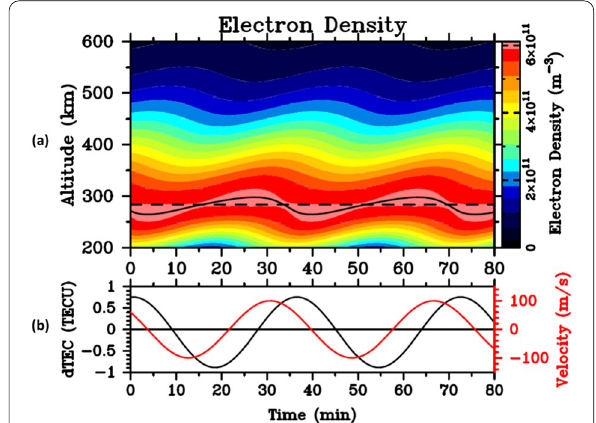
Fig. 8 a Model calculation of electron density in the F region for the case the electric field oscillating with a period of 36 min and B drift. Solid line and dotted line amplitude of 100 m/s for E × indicate peak altitude of electron density and original peak altitude of electron density without electric field oscillation, respectively. b Temporal variation of TEC (black) and plasma drift velocity (red) perturbations. TEC is an integration of the electron density from 200 to 600 km in